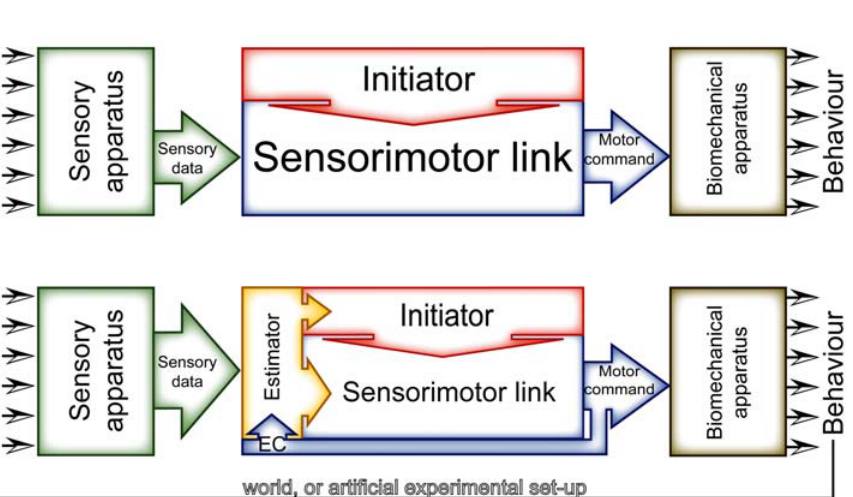
Figure 7. Suggested models for open-and closed-loop experiments. A–Open-loop model as proposed in Fig. 1b (for the openloop group). B– Closed-loop model (for the onestripe and uniform groups). Performance in a situation with a closed reafferent feedback loop is commonly modeled with a state estimator, cross-correlating sensory input with recent motor commands via an efference copy (EC). Such an evaluation is required for efficient behavioral control of incoming sensory